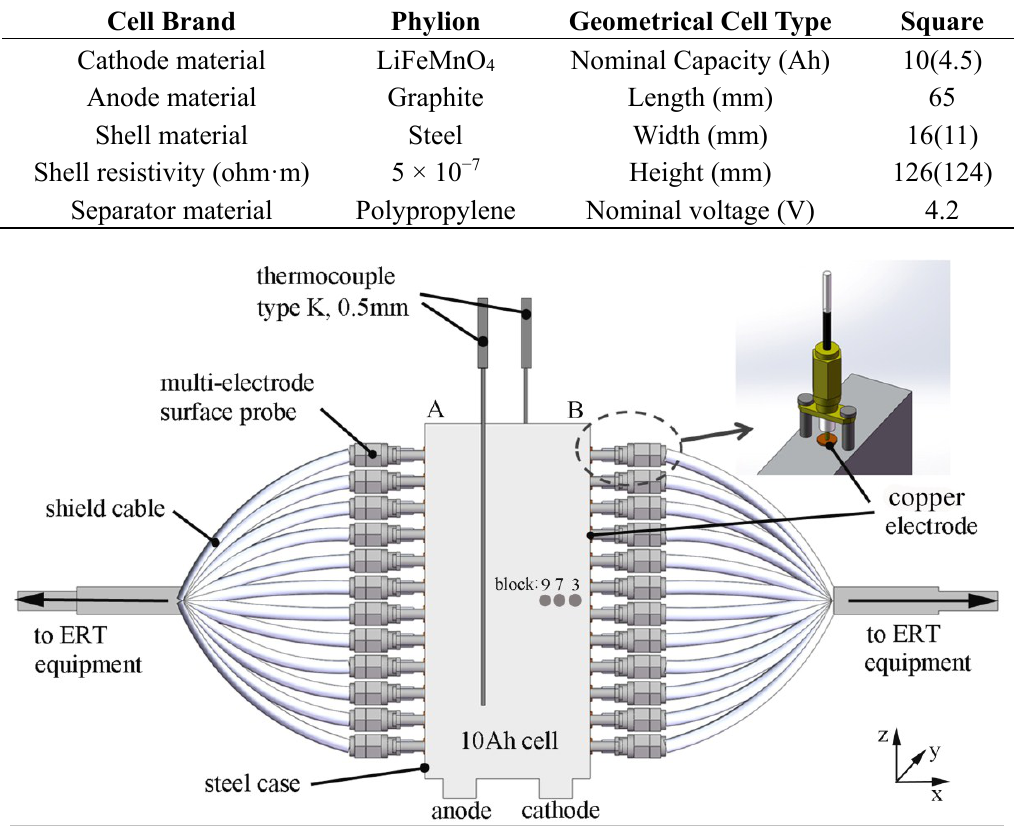
Table 1. Specifications of the investigated Li-ion cells.